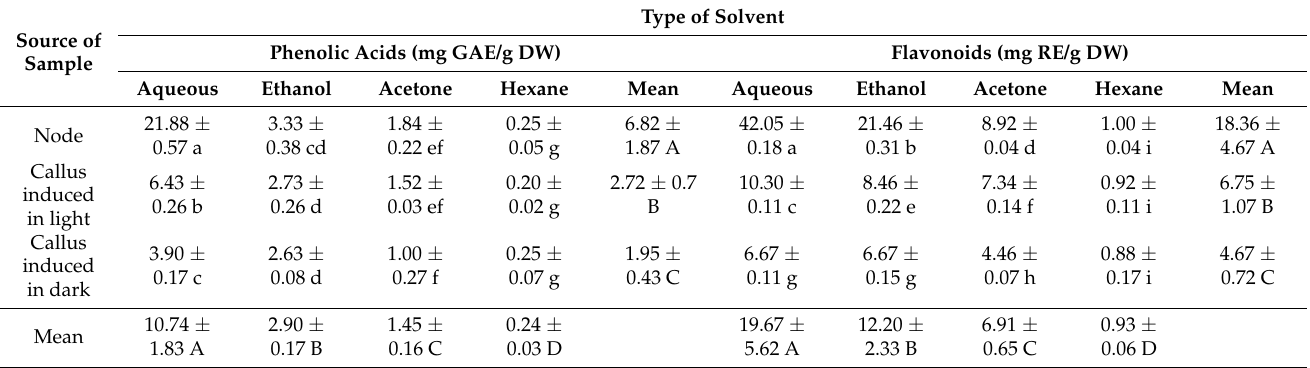
Table 3. Total phenolic acids and flavonoids contents of node and in vitro-induced calli of Bougainvil- lea glabra